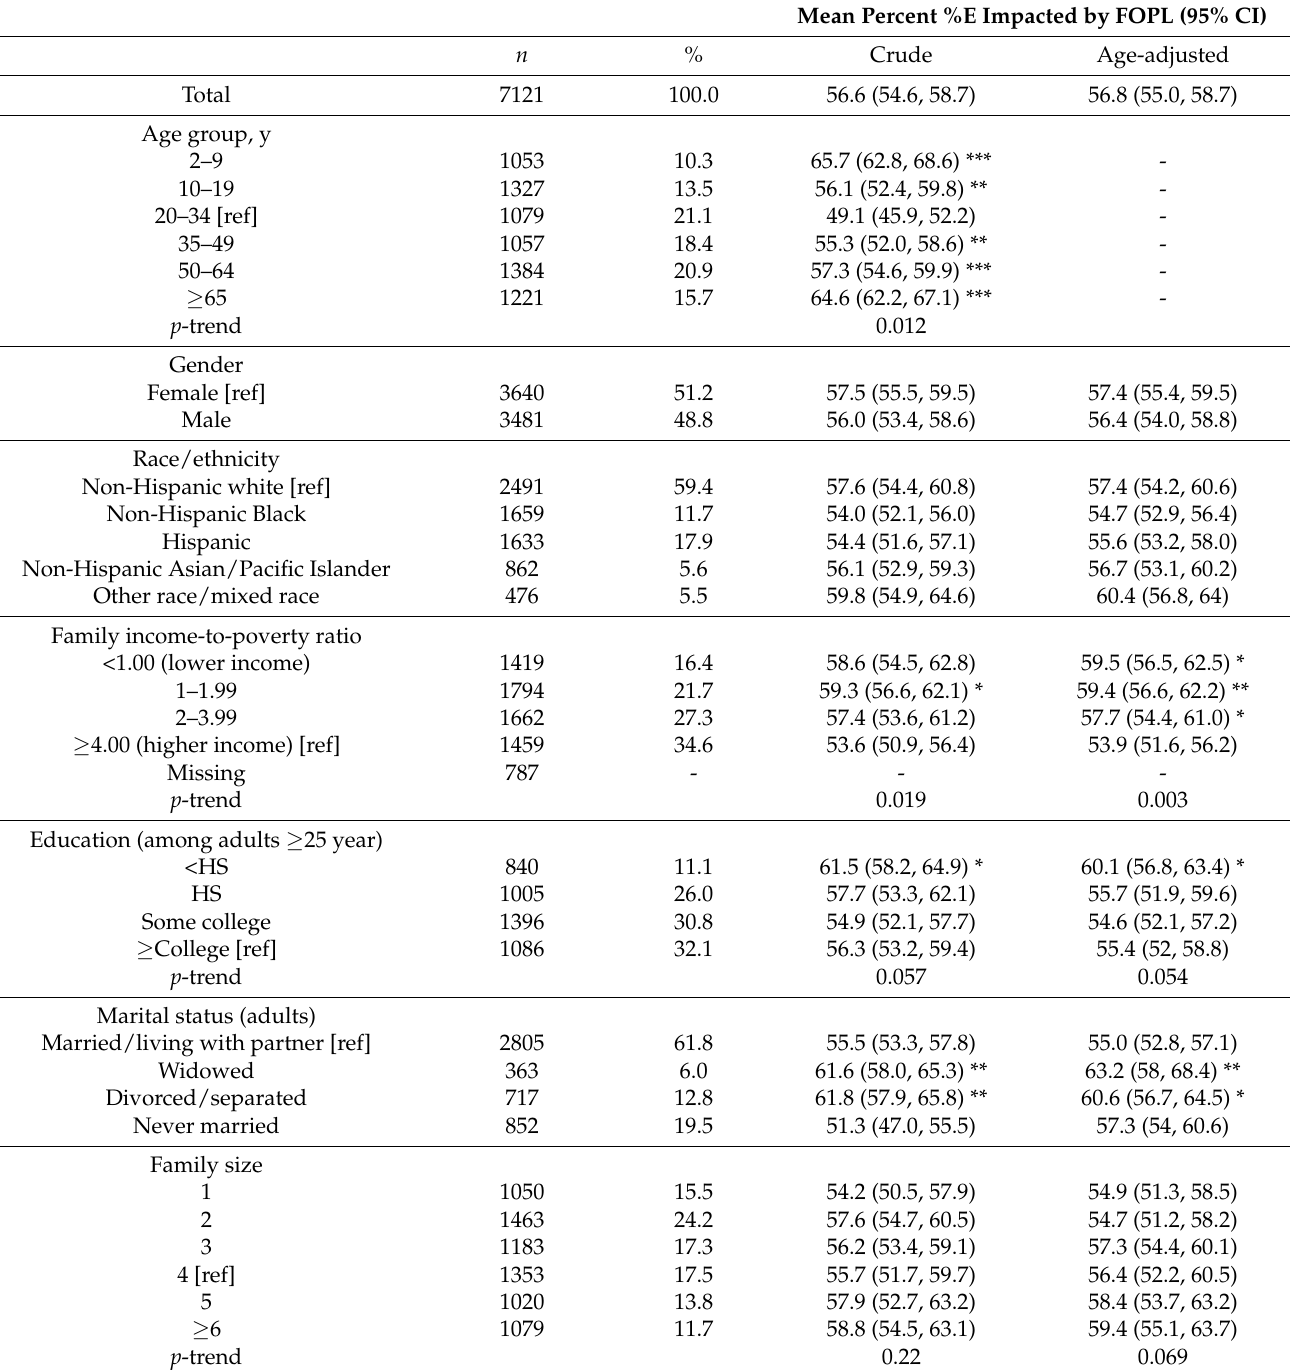
Table 1. Population characteristics and proportion of daily dietary energy impacted by FOPL (front of package labeling) in the United States,